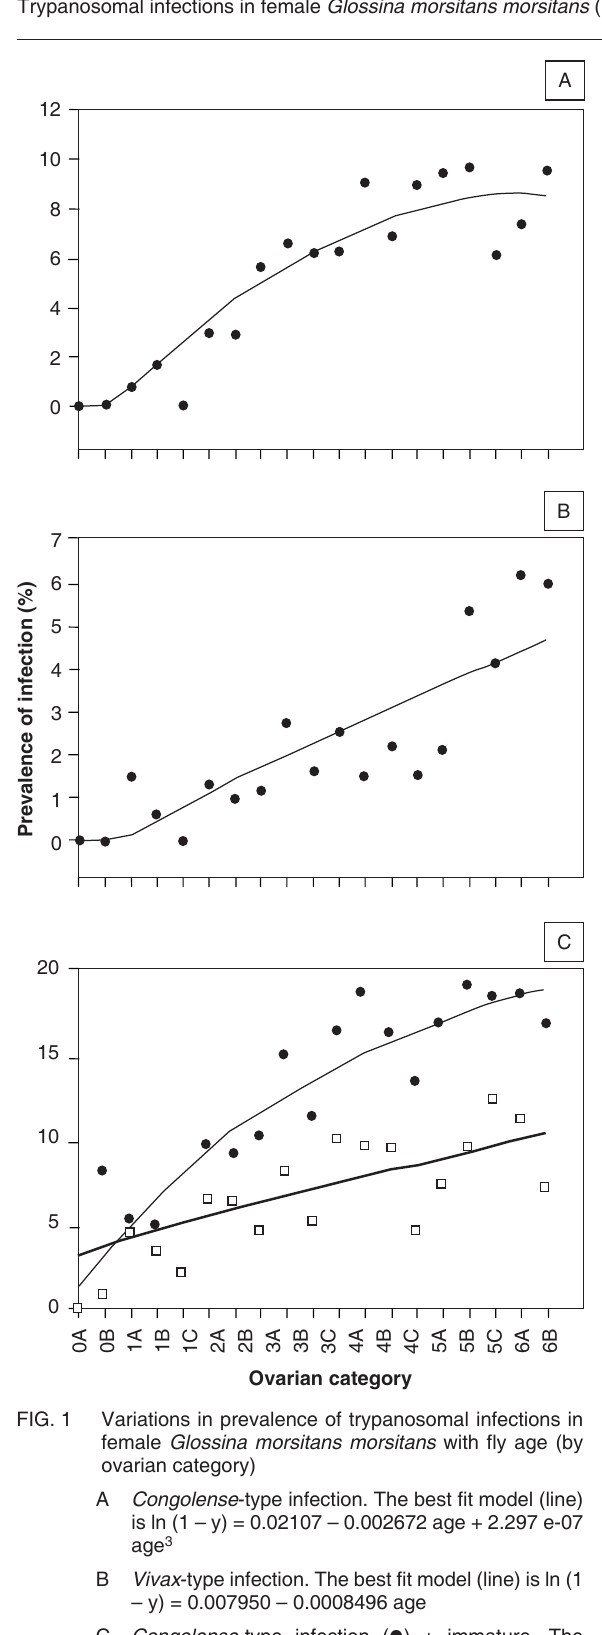
FIG. 1 Variations in prevalence of trypanosomal infections in female Glossina morsitans morsitans with fly age (by ovarian